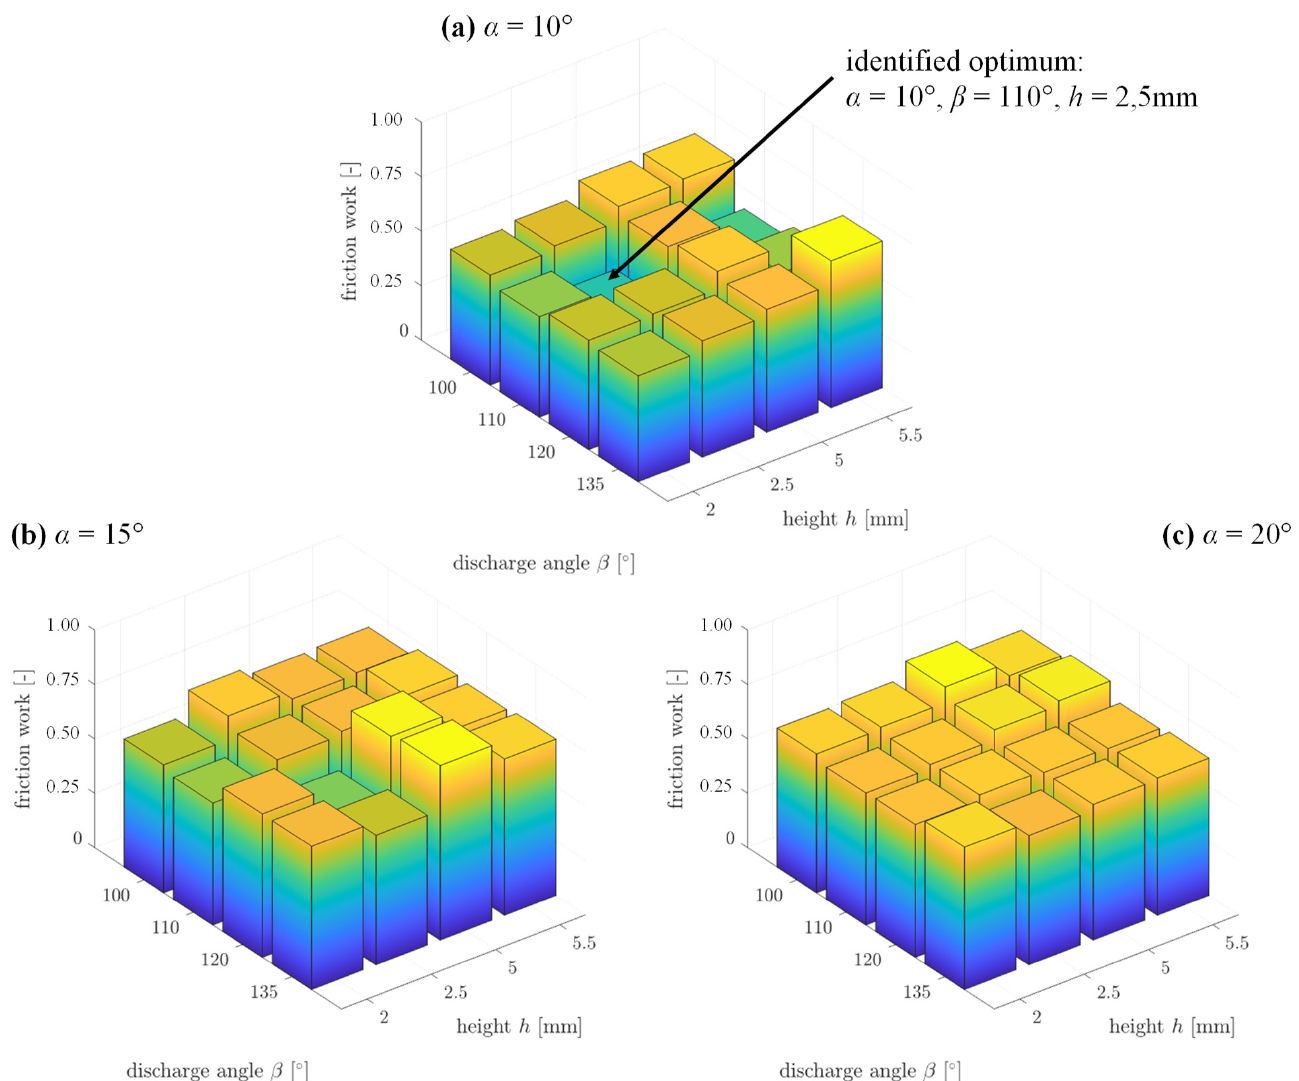
Figure 12. Simulation results of the friction work of the full factorial parameter study: Angle α = 10° ( a ), angle α = 15° ( b ), and angle α = 20° ( c ).